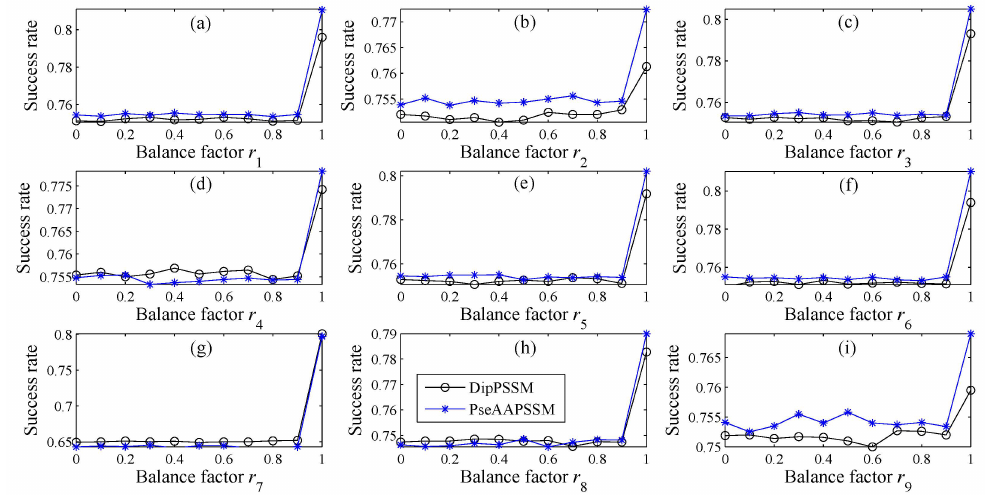
Figure 2. Success rate comparison for different r i with our representations on Dataset 1, where each subplot, from ( a ) to ( i ), respectively represents each sub-nuclear location.